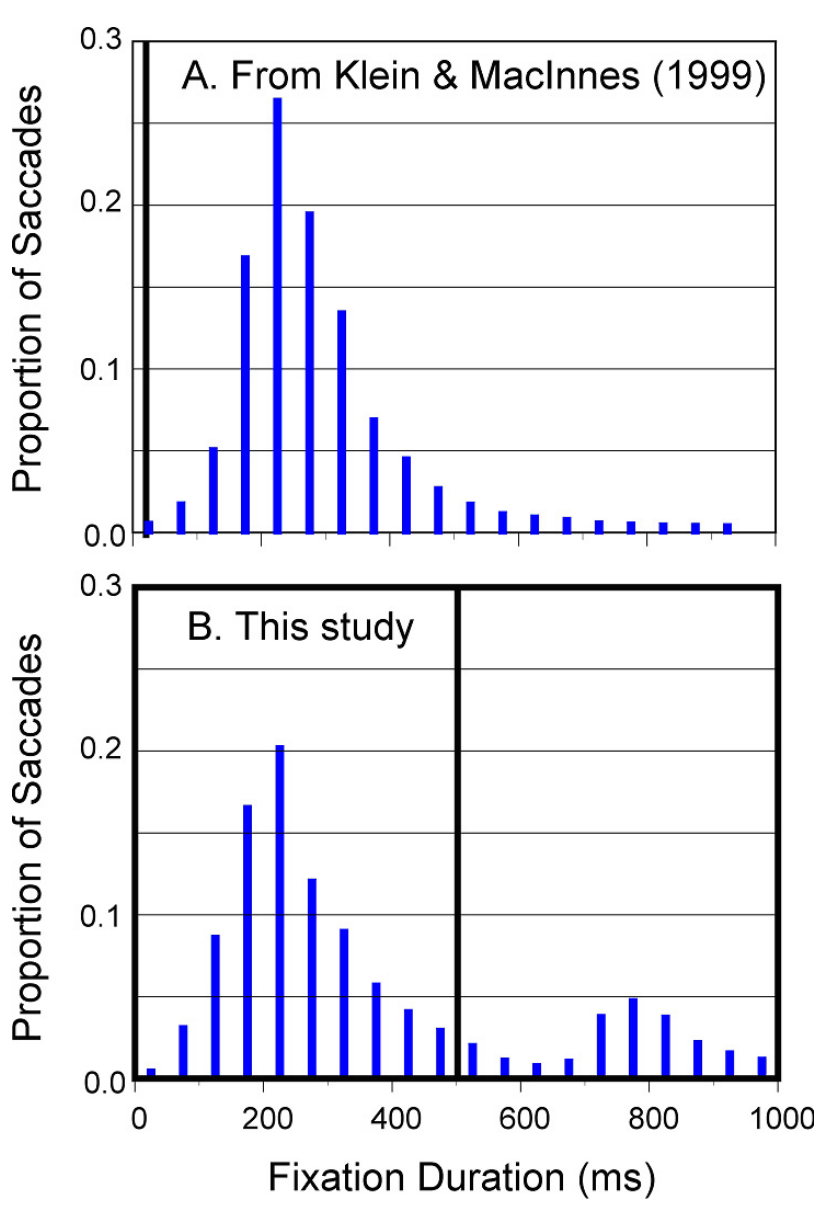
FIGURE 3 . Proportion of saccades leading to different fixation durations is plotted as histograms. (a) Klein and MacInnes [1], experiments 1 and 2 combined; (b) current study. The time of probe delivery is shown by black vertical lines positioned at 20 ms and 500 ms, in (a) and (b),